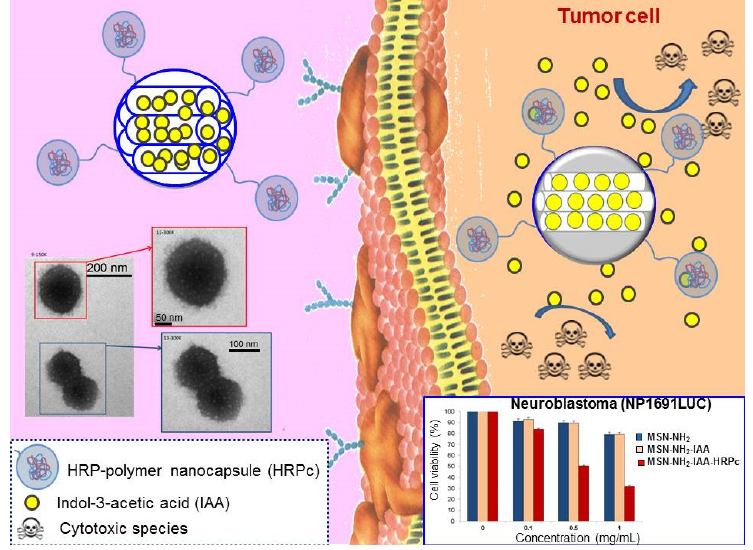
Figure 7. Schematic illustration of the in situ cytotoxic generation for antitumor therapy [139]. (i) Functionalization of MSNs with amino group (MSN-NH 2 ); (ii) loading of the pro-drug indol-3-acetic acid (IAA) (MSN-NH 2 -IAA); grafting of an enzyme horseradish peroxidase (HRP)-polymer nanocapsule to the external surface of the nanosystem (MSN-NH 2 -IAA-HRPc). TEM images of the nanosystem and cytotoxicity studies with neuroblastoma cells are also